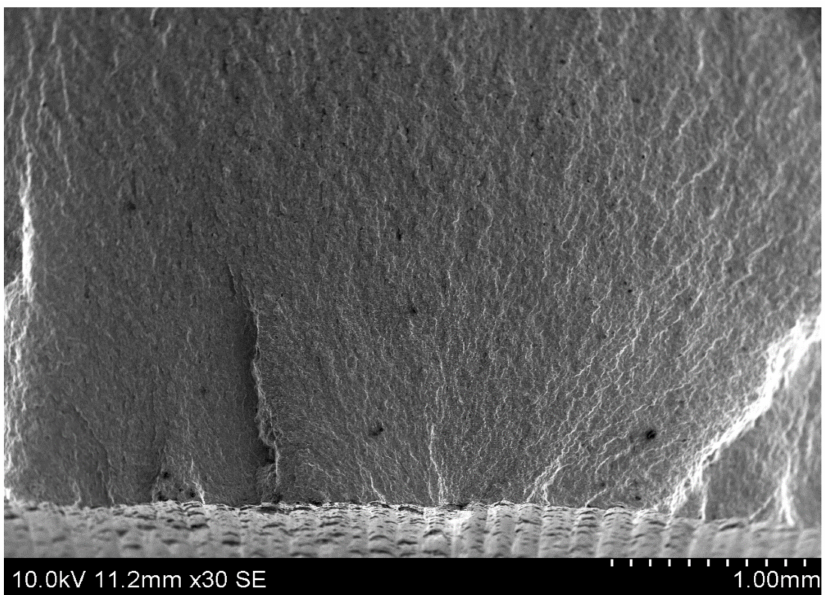
Figure 12. Initial fatigue crack path (24.3 mm) of the tested specimen with stop hole ( ∆ K = 40 MPa × m 0.5 ), crack growth direction from bottom to top, fracture surface located close to drilled hole with reinitiated fatigue crack.